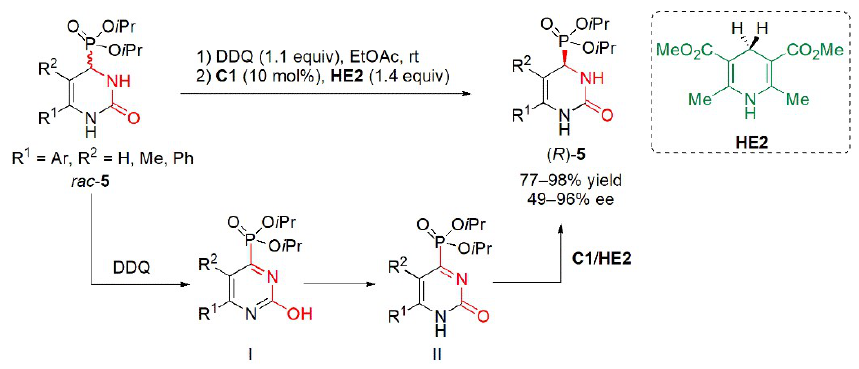
Figure 4. Redox deracemization of phosphonate-substituted dihydropyrimidines [40]. b.